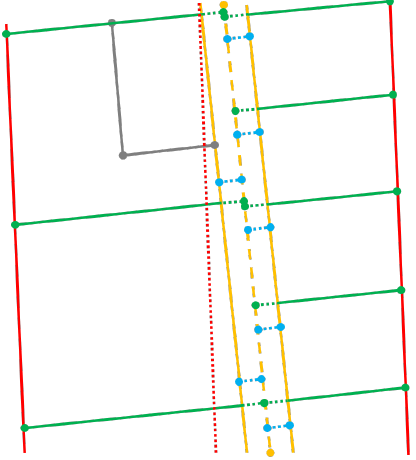
Figure 2. External shell (red) and its center line (red dashed), corridor walls (orange) and corridor center line (orange dashed), corridor-depending walls (green), walls not depending on the corridor (grey), door centroids